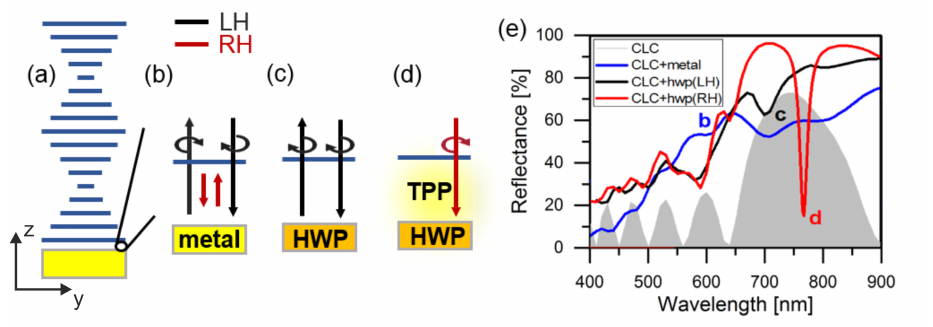
Figure 1. ( a ) Schematic of the right-handed helical CLC combined with a bottom film. Polarization dynamics of the light between ( b ) CLC and a metal mirror and ( c , d ) CLC and a half-wave plate metasurfaces. ( e ) Reflectance spectra of CLC–metal and CLC-half-wave plate simulated by the software for Multiphysics simulation COMSOL. The rotation arrow direction indicates the right- handed (RH) and the left-handed (LH) circular polarizations propagating along the z axis. The center of the CLC stopband is at 750 nm. The refractive index of the SiO 2 layer is fixed at 1.45, and that of the gold nanobrick and PMMA layer comes from the databases of Johnson and Christy [21] and Sultanova [22], respectively. The full reflectance spectra of the measurements is presented in the Supplementary